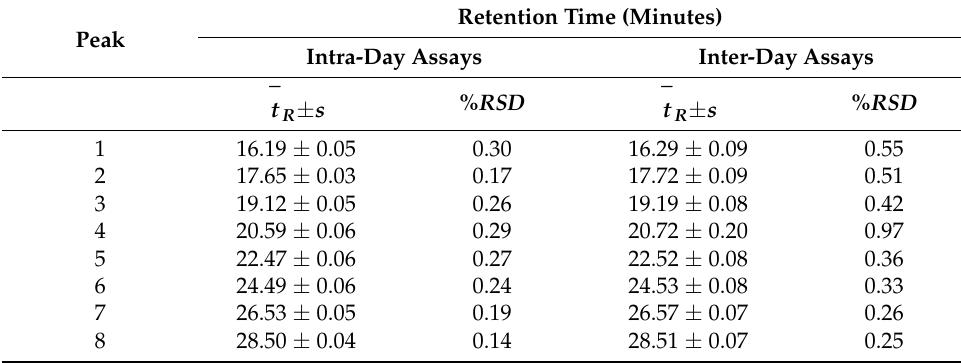
Table 1. Intra- and inter-day variabilities for TAGs retention times (15 injections).